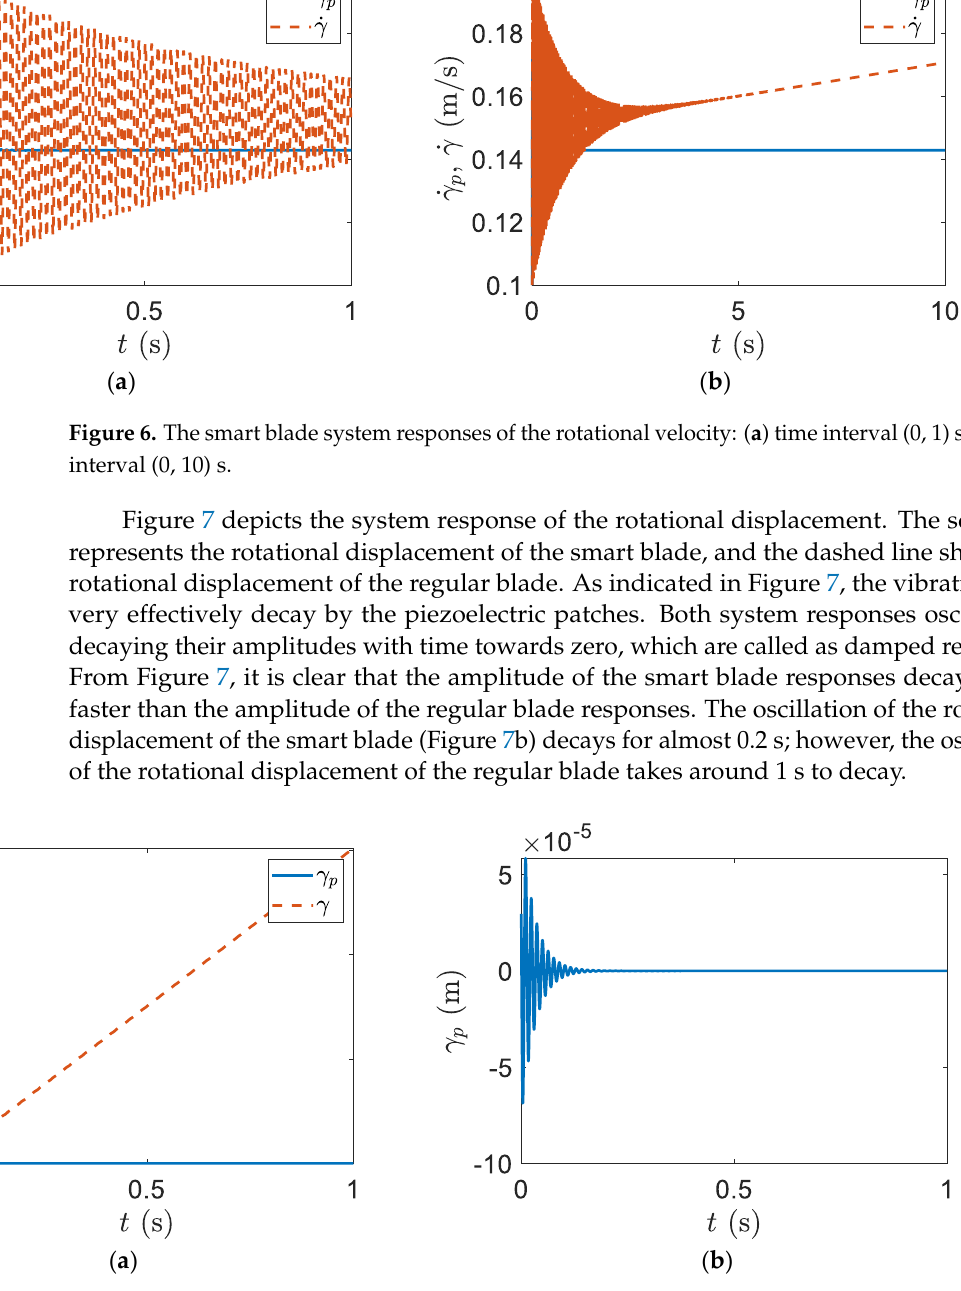
( b ) Figure 5. Phase planes for the electrical current and the charge: ( a ) flapwise trajectory; ( b ) edgewise trajectory. Figure 6 depicts the system response of the rotational velocity. The solid line repre- sents the rotational velocity of the smart blade, and the dashed line shows the rotational